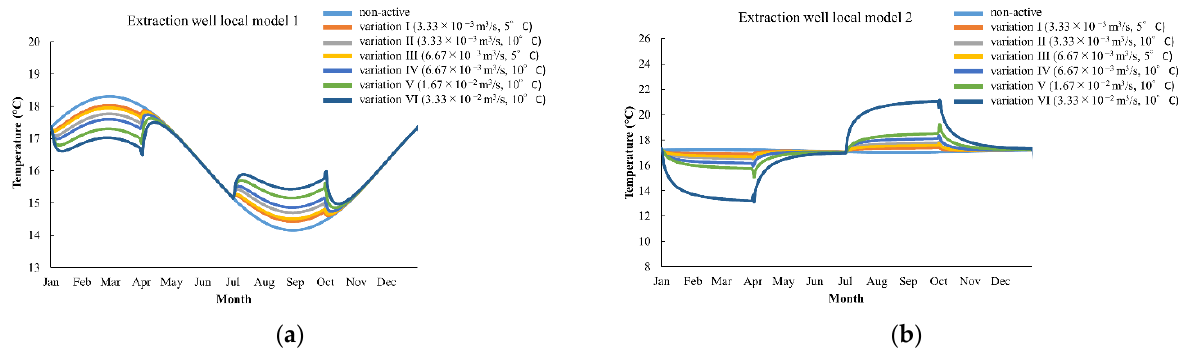
Figure 17. Groundwater temperature at extraction well on local models 1 (a) and local model 2 (b).